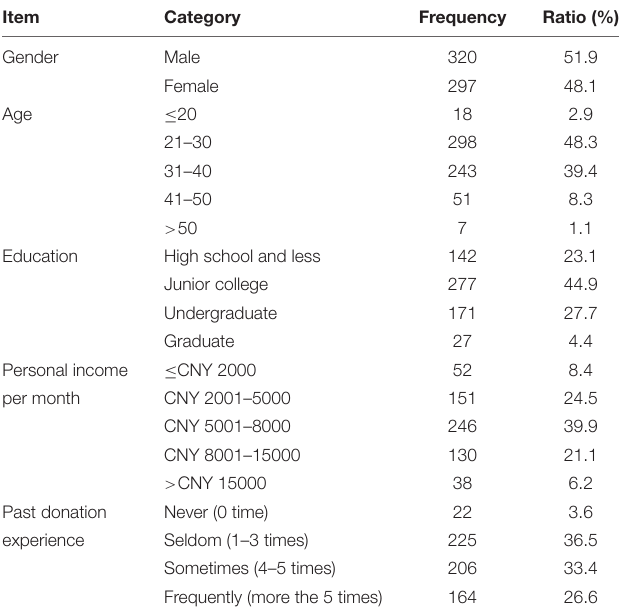
TABLE 1 | Demographic characteristics of the sample ( n =